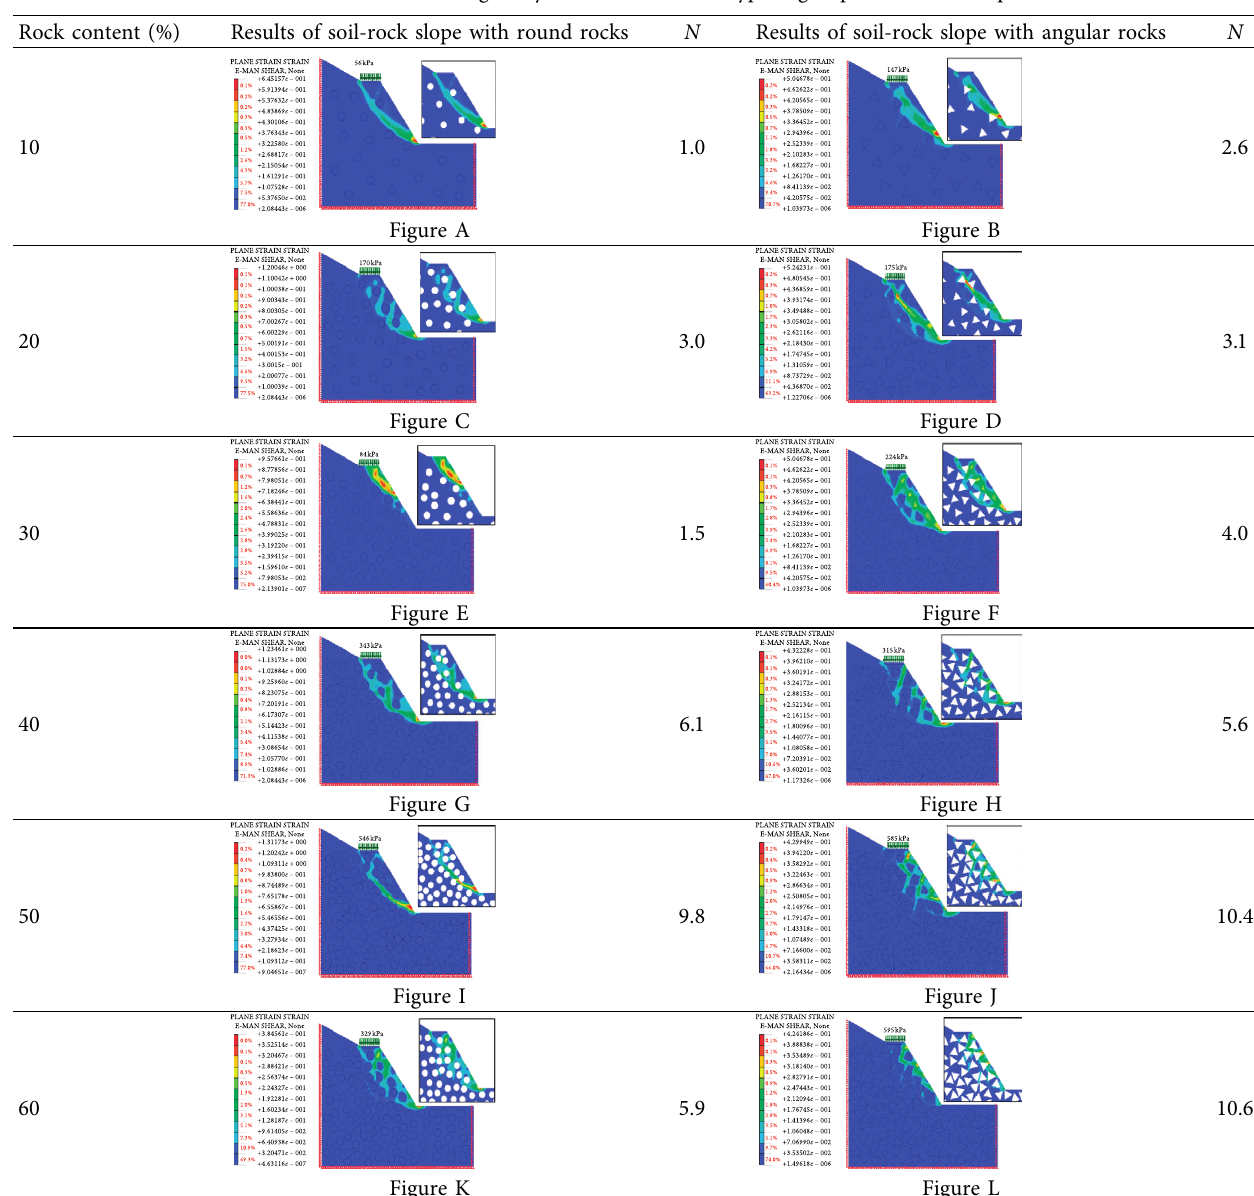
Table 3: Ultimate loading analytical results for one typical group of soil-rock